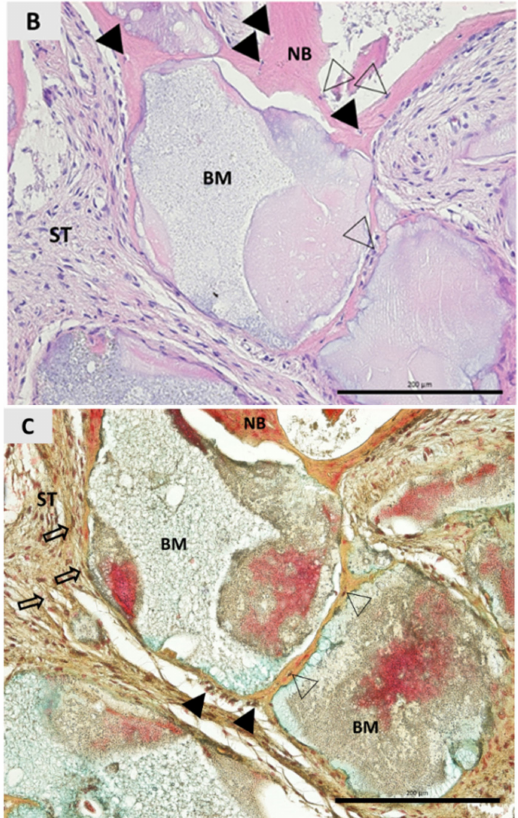
Figure 3. Histological examination of the bone biopsy taken six months post-implantation. ( A ) Longitudinal section of sample harvested from the augmented area. ISBG granules are completely consolidated with newly formed bone starting at the periphery border between the ISBG and pre-existing defect. The area of interest is marked by a square and shown in higher magnification (hematoxylin and eosin staining; magnification 10 × ). ( B ) Closer look at the area of interest. The residual ISBG is in close contact with a newly formed bone. There is no sign of inflammatory tissue response. Osteocytes are trapped into bone tissue, while active osteoblasts can be detected at the peripheral regions of residual ISBG and newly formed bone (hematoxylin and eosin staining; magnification 20 × ). ( C ) ISBG granules are integrated and in close contact with the newly formed bone six months post-implantation. Osteocytes and osteoblasts can be detected in the newly formed bone. Soft tissue area is rich with cells, mainly fibroblasts. Note the dark red areas that indicate new bone formation at the ISBG and bone contact. No signs of inflammatory tissue response towards the implanted ISBG. NB, newly formed bone; BM (biomaterial), residual ISBG; ST, soft tissue; black filled triangles: osteocytes; unfilled triangles: osteoblast; arrows: fibroblasts (Movat’s pentachrome staining, magnification 20 ×